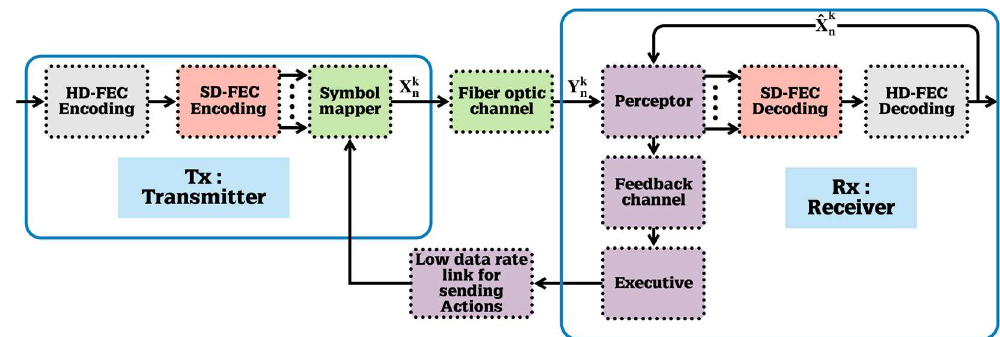
Figure 5. The basic design for quality of service (QoS) control and bit error rate (BER) improvement by CDS for the fiber-optic link. (HD-FEC = hard decision forward error correction, SD-FEC = soft decision forward error correction).